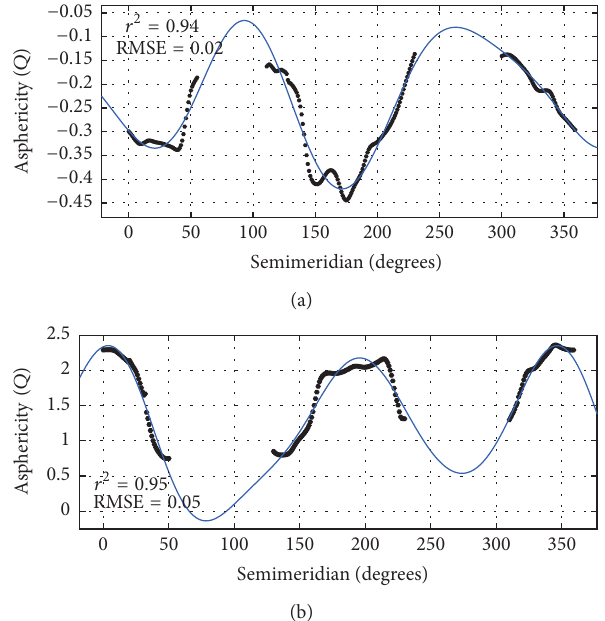
Figure 3: Typical example of the asphericity variation ( 𝑄 ) as a function of semimeridian for subject number 15 before (a) and after (b) surgery. Black: the 𝑄 -value of each semimeridian in the horizontal region. Blue: the fitted curve of the 𝑄 -value 360- semimeridional variation. 𝑟 2 : goodness of fit of the Fourier function. RMSE: root mean square